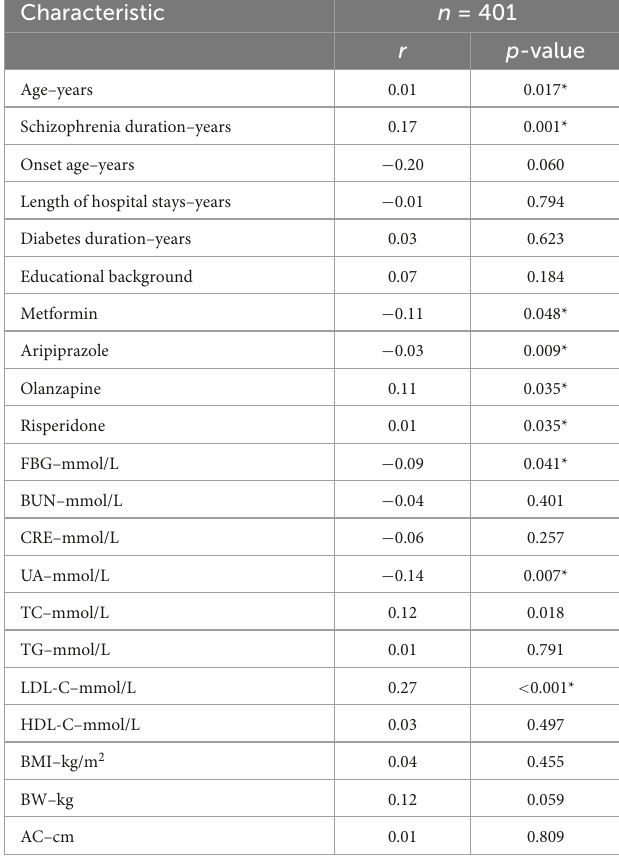
TABLE 2 Factors associated with PRL levels in patients with schizophrenia co-type 2 diabetes